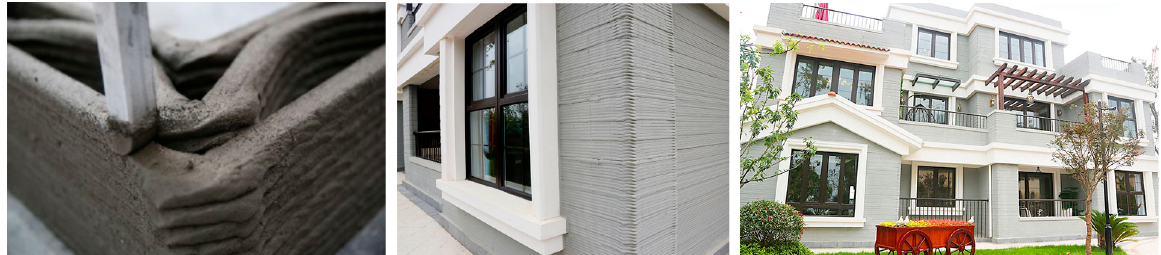
Figure 18. A 3D ‐ printed three ‐ story villa by Winsun in Wujiang, China. Figures reproduced with Figure 18. A 3D-printed three-story villa by Winsun in Wujiang, China. Figures reproduced with permission from [198]. permission from [198].